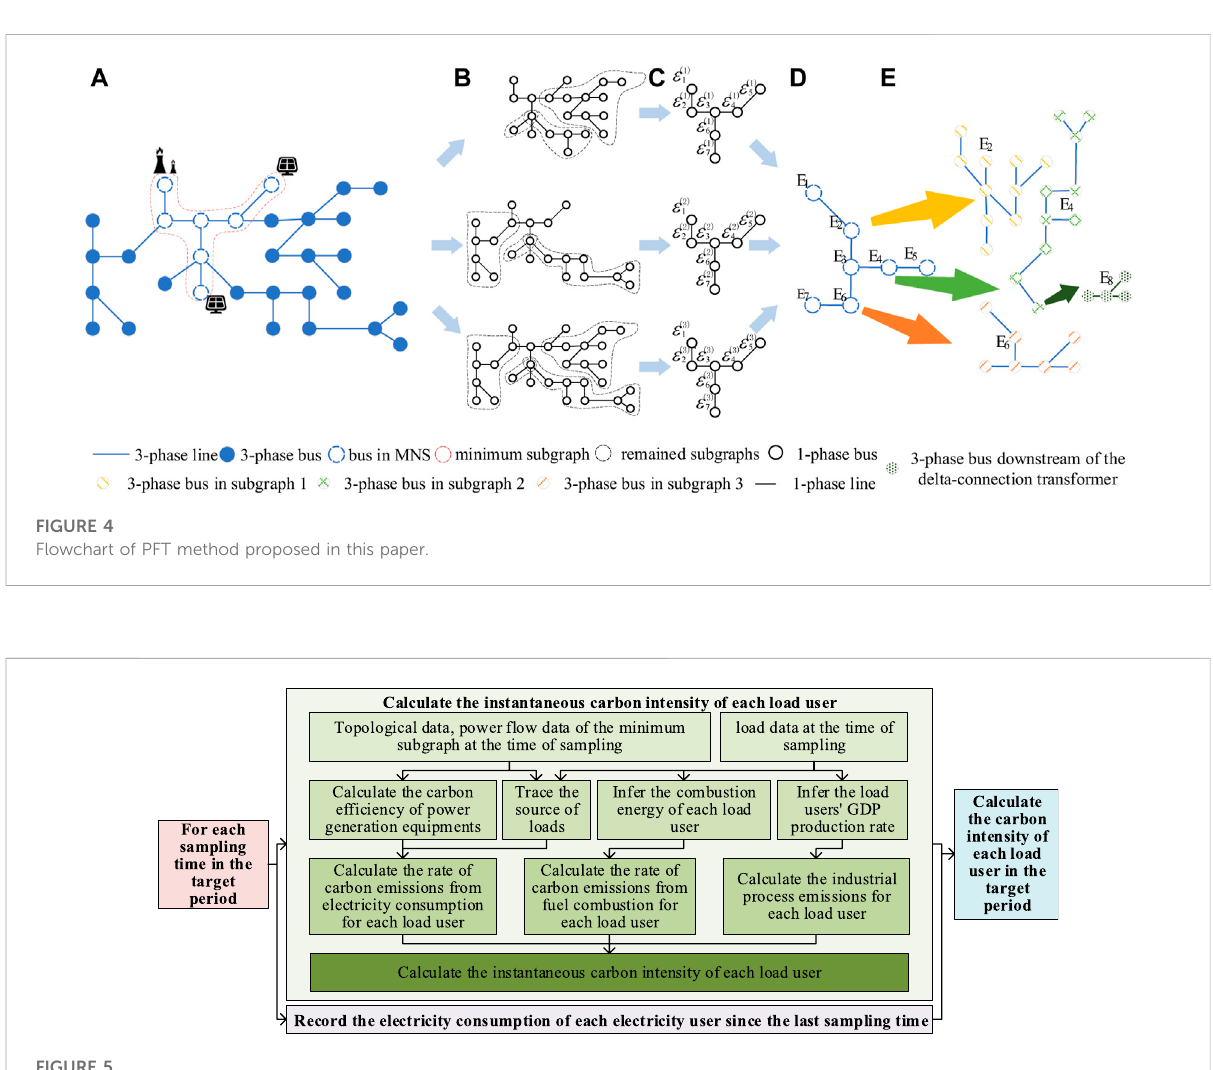
FIGURE 5 Flowchart of the CI calculation